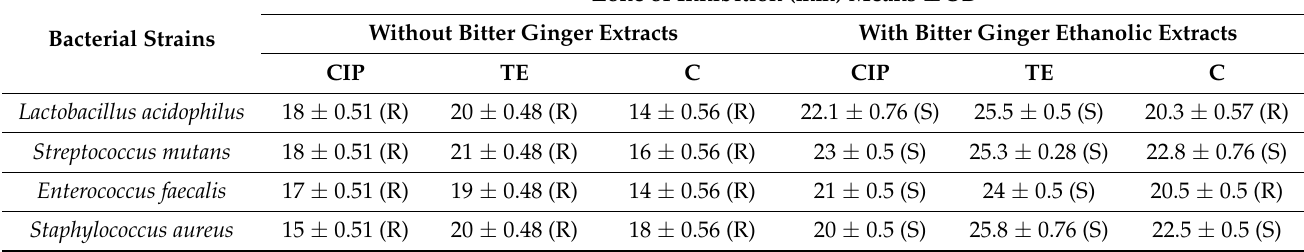
Table 5. Antibiotic susceptibility testing of the bacterial isolates with and without the bitter ginger ethanolic